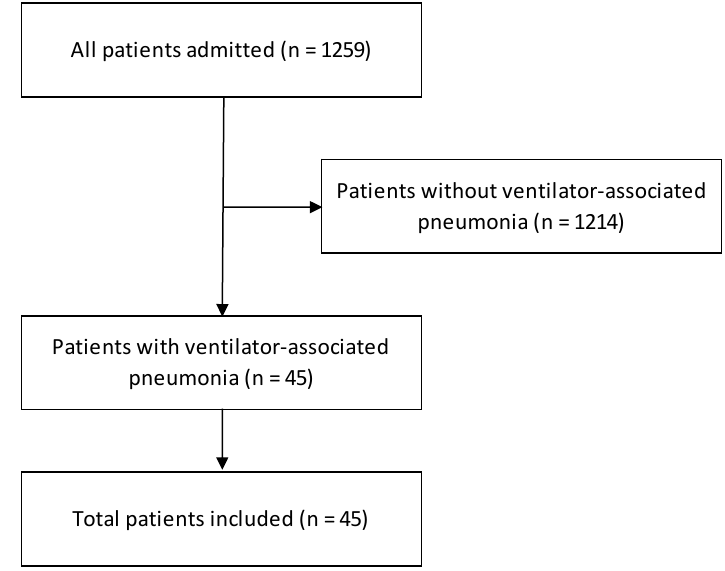
Figure 1. Flowchart of patient inclusion criteria.